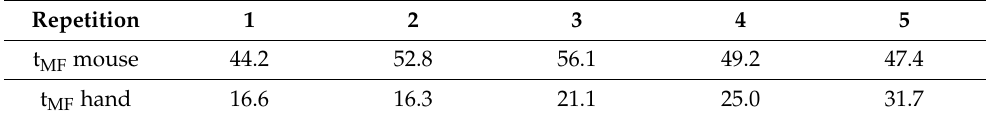
Table 2. Values obtained with t MF as a marker to distinguish nonlinear from linear processes in multifractality of time series. Here, the level of significance ( p < 0.05) corresponded to t MF > 2.02, which means that t MF in each condition was highly